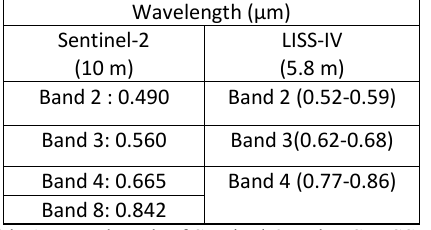
Table 1: Wavelength of Sentinel-2 and IRS LISS-IV 2.2. IRS LISS IV: LISS IV has three spectral bands with